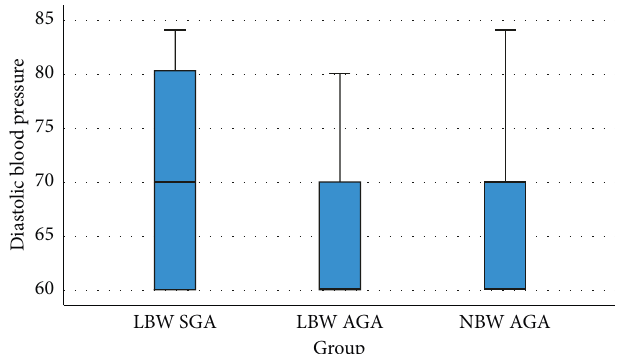
Figure 2: Box plot association between birth weight and diastolic blood pressure of children with a history of LBW AGA, LBW SGA, and NBW